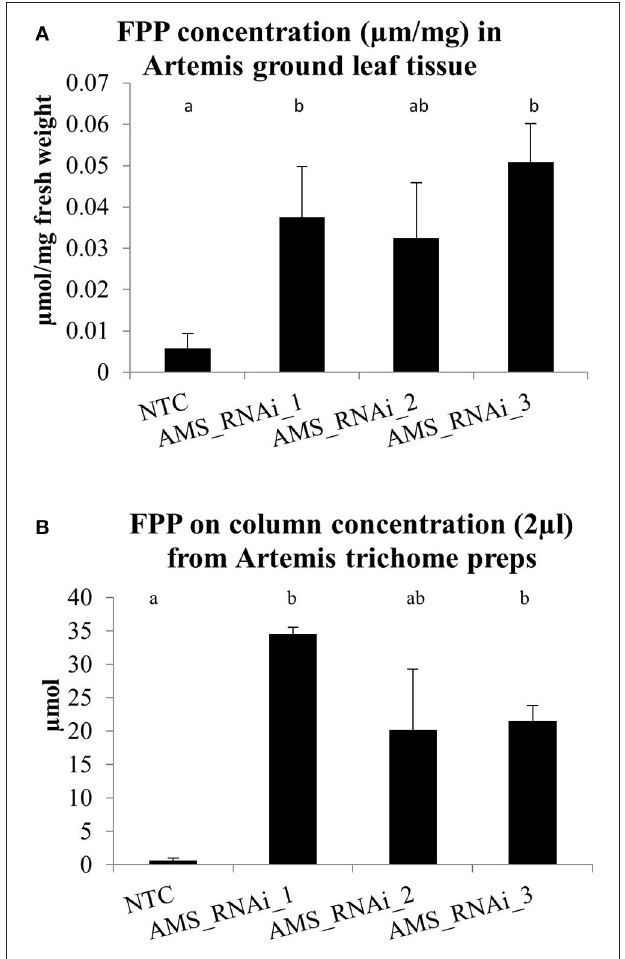
FIGURE 5 | (A) FPP concentrations in µ mol/g for ground young leaf material for the Artemis NTC and Artemis AMS silenced lines (concentrations were measured on Thermo Orbitrap Fusion Tribrid mass spectrometer). Error bars ± SD (NTC— n = 6, AMS _RNAi lines— n = 3). (B) On column FPP concentrations in µ mol measured from isolated trichome extracts for Artemis NTC and Artemis AMS silenced lines (concentrations were measured on a Thermo LTQ Orbitrap Classic instrument, used in ion trap mode). Error bars ± SD (NTC— n = 6, AMS _RNAi lines— n = 3). Letters represent Bonferroni test results after ANOVA, groups not sharing letters indicate statistically significant differences ( p ≤ 0.05).